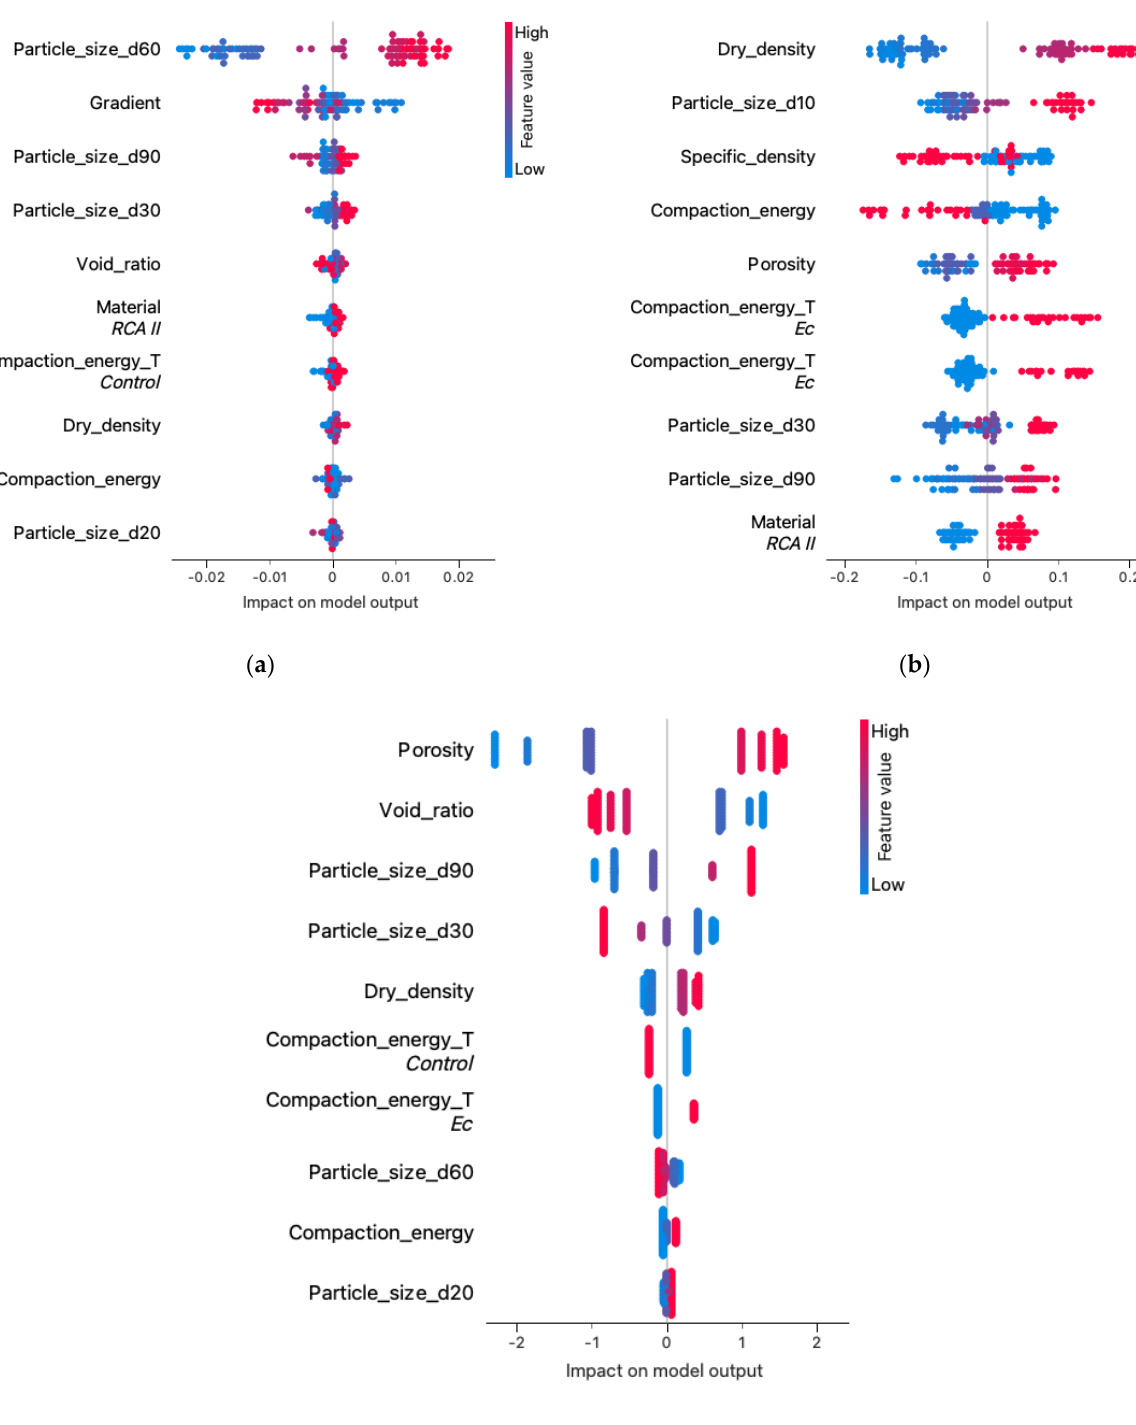
Figure 9. The structure feature values at the impact on the model in different algorithms: ( a ) kNN. ( b ) Neural network. ( c ) Linear regression.